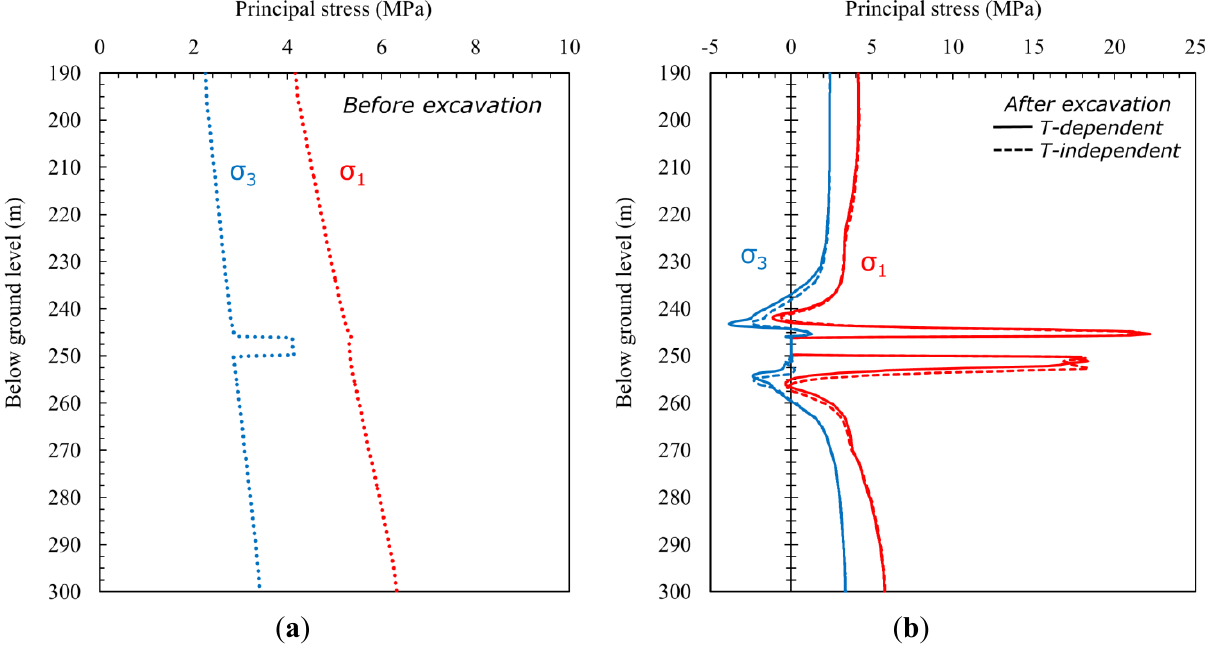
Figure 9. Profile of maximum ( σ 1 = σ V ) and minimum ( σ 3 = σ H ) principal stresses at the left model boundary plotted against depth ( a ) before excavation (initial stress state) and ( b ) after 50 days of simulation with temperature-dependent and -independent